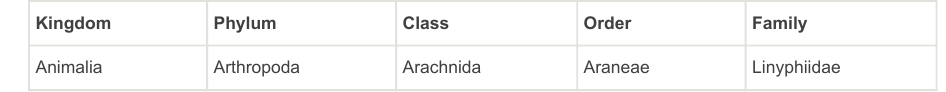
Kingdom Phylum Class Order Family Animalia Arthropoda Arachnida Araneae